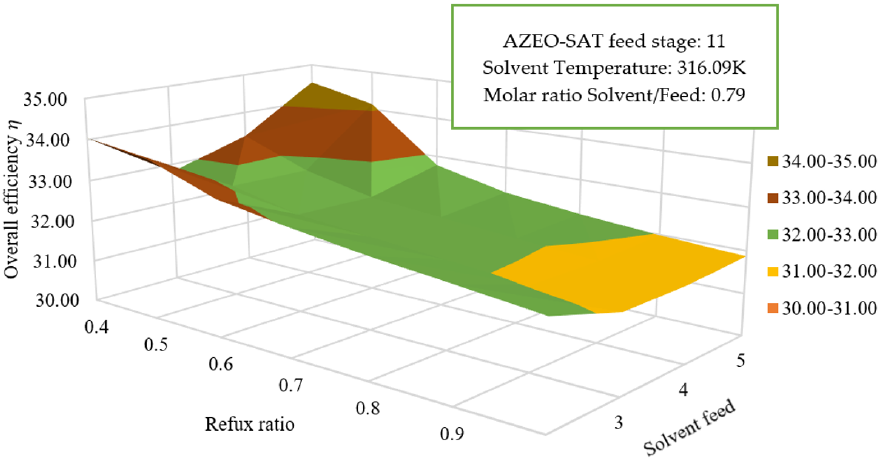
Figure 5. Variation of reflux ratio and solvent feed on the overall efficiencies of the process.